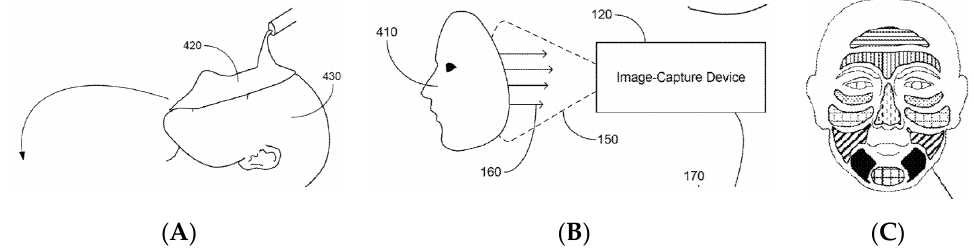
Figure 38. ( A ) Application of the settable material on the face of the subject. This settable material